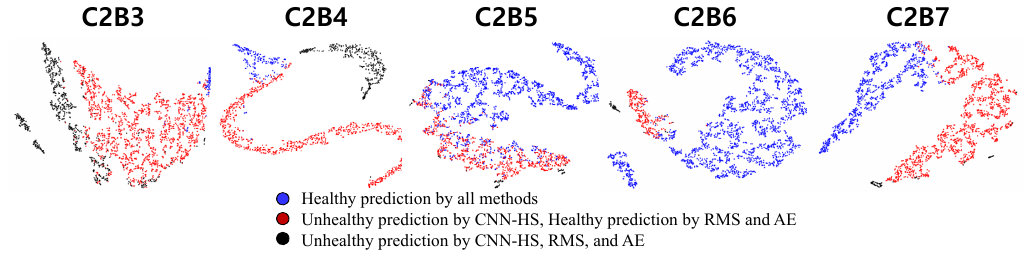
Figure 12. Feature maps of CNN-HS using t-SNE with PCA (condition